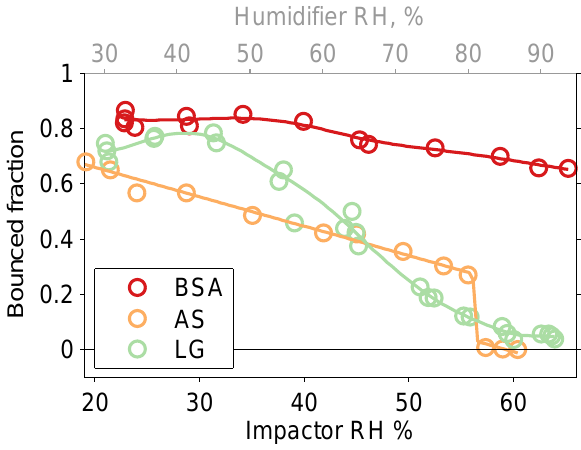
Fig. 3. Reference bounce characteristics of ammonium sulfate (AS) (crystalline), bovine albumin serum (BSA) (amorphous) and lev- oglucosan (LG)